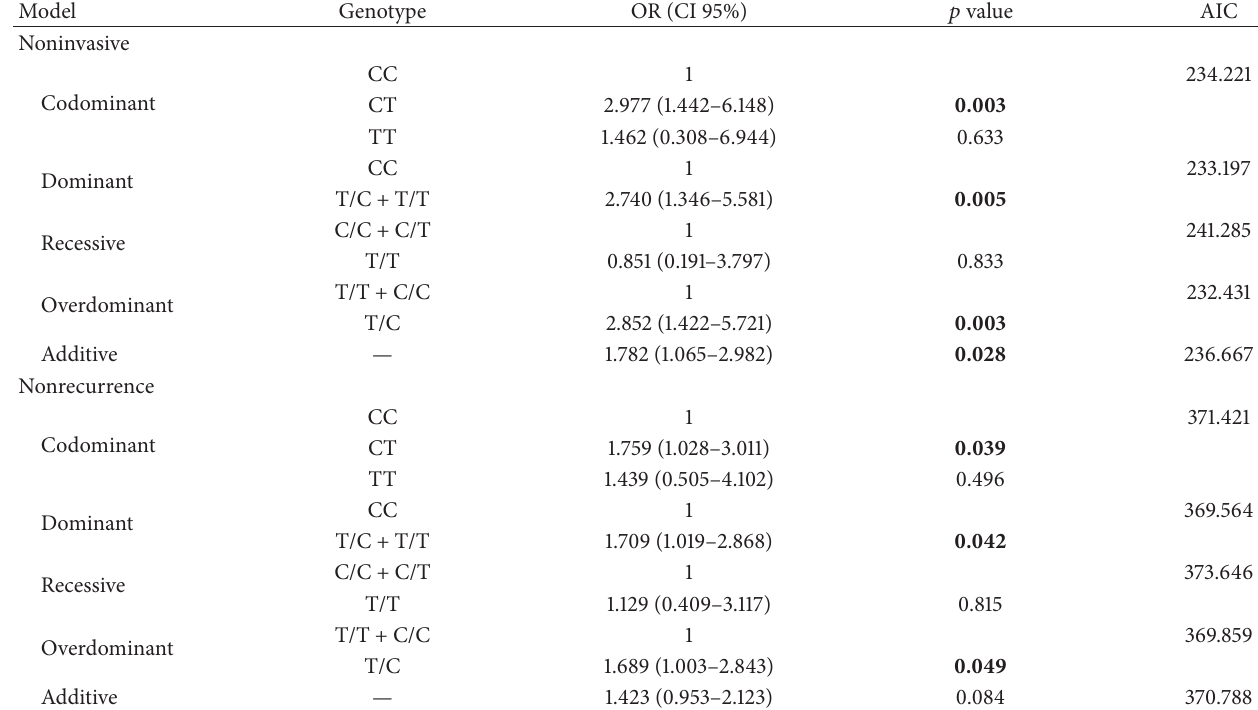
Table 8: Binomial logistic regression analysis in noninvasive and nonrecurrence pituitary adenoma (PA) and in the control group.